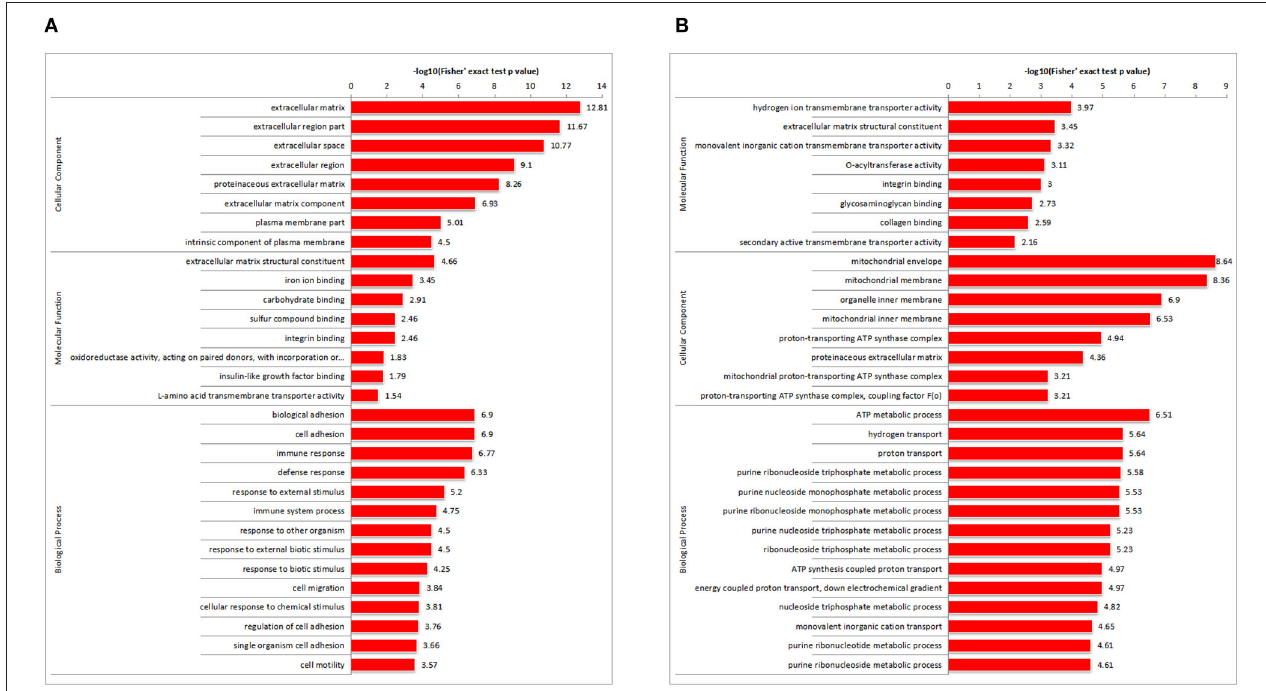
FIGURE 4 | GO enriched histogram of DAPs. Statistics of GO enrichment in RM vs. M (A) and RM vs. R (B) . Each column in the figure is a GO term, the vertical axis text indicates the name and classification of GO, and the height of the column indicates the enrichment rate. R, REV-infected CEF cells; M, MDV-infected CEF cells; RM, REV and MDV coinfected CEF cells. GO, Gene Ontology; DAPs, differentially accumulated proteins; REV, reticuloendotheliosis virus; CEF, chicken embryo fibroblast; MDV, Marek’s disease